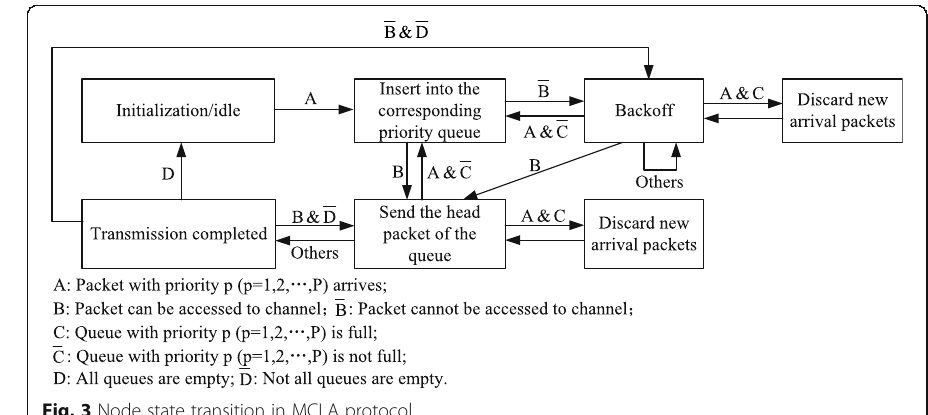
Fig. 3 Node state transition in MCLA